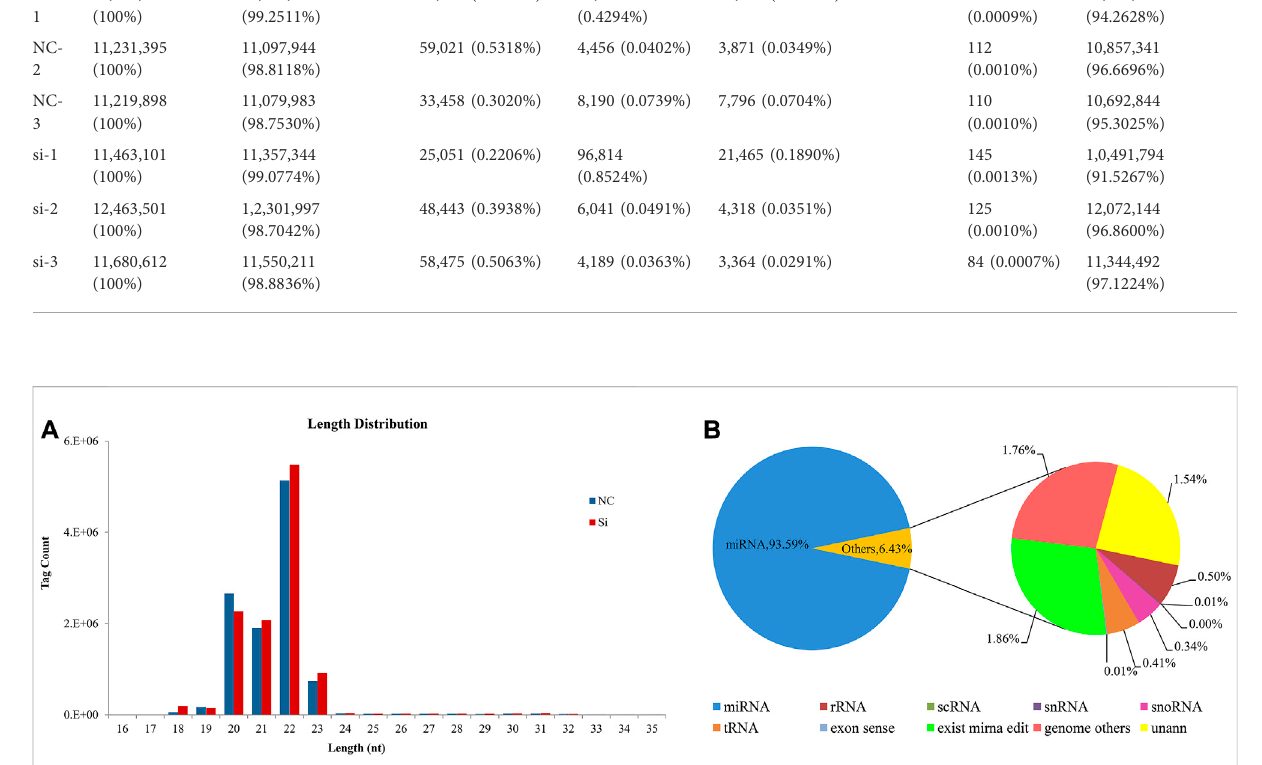
FIGURE 1 Correlation analysis of small RNA sequencing data. (A) Statistical analysis of small RNA fragment size. (B) Statistical analysis of the types of small RNA fragments after comparison with the database, including miRNA (existing miRNAs, known miRNAs and novel miRNAs), rRNA, scRNA,